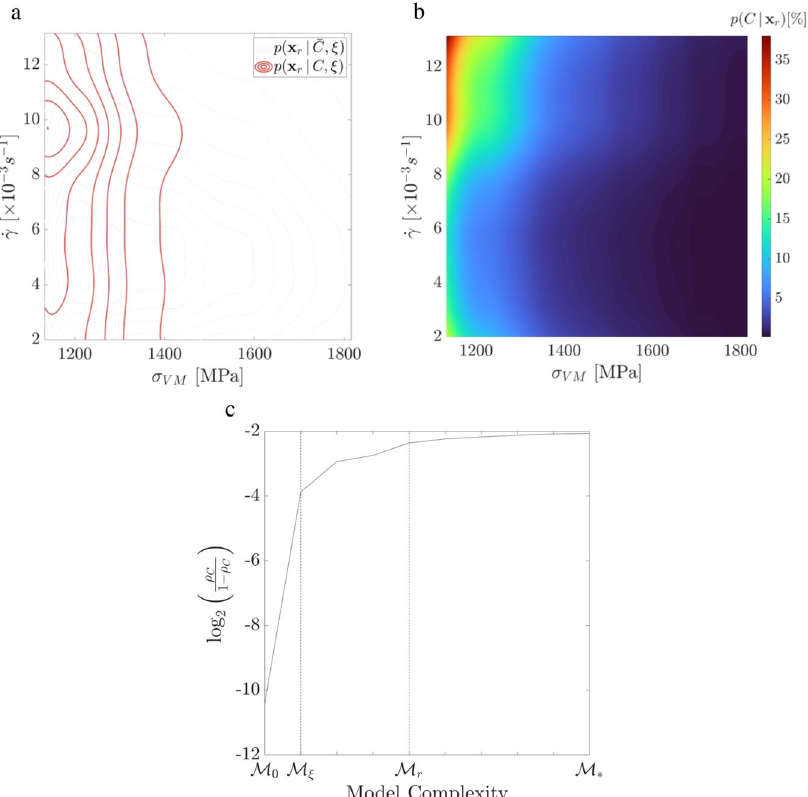
Fig. 4 Illustration of crack nucleation model performance. a 2D projection of the iso-probablistic contours of the fi nal uncracked and cracked likelihood PDFs, and b 2D projection of the fi nal posterior joint PDF indicating high crack probability at low σ VM and high _ γ values. c Log-odds of the geometric mean of the probability of correct crack nucleation prediction for increasingly model complexity. The included models are M 0 ¼ p ð C Þ , M ξ ¼ p ð C j ξ Þ , M r ¼ p ð C j ξ ; x r Þ , and M (cid:4) ¼ p ð C j ξ ; x (cid:4) Þ